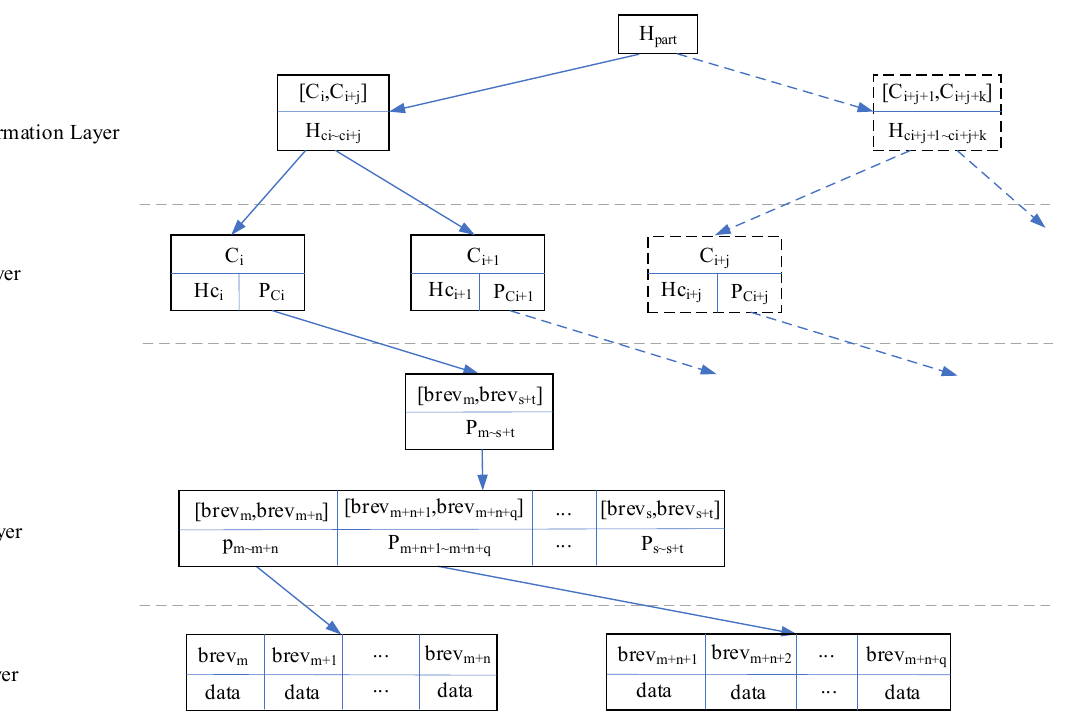
Figure 6. The schematic diagram of the rank B+ tree.